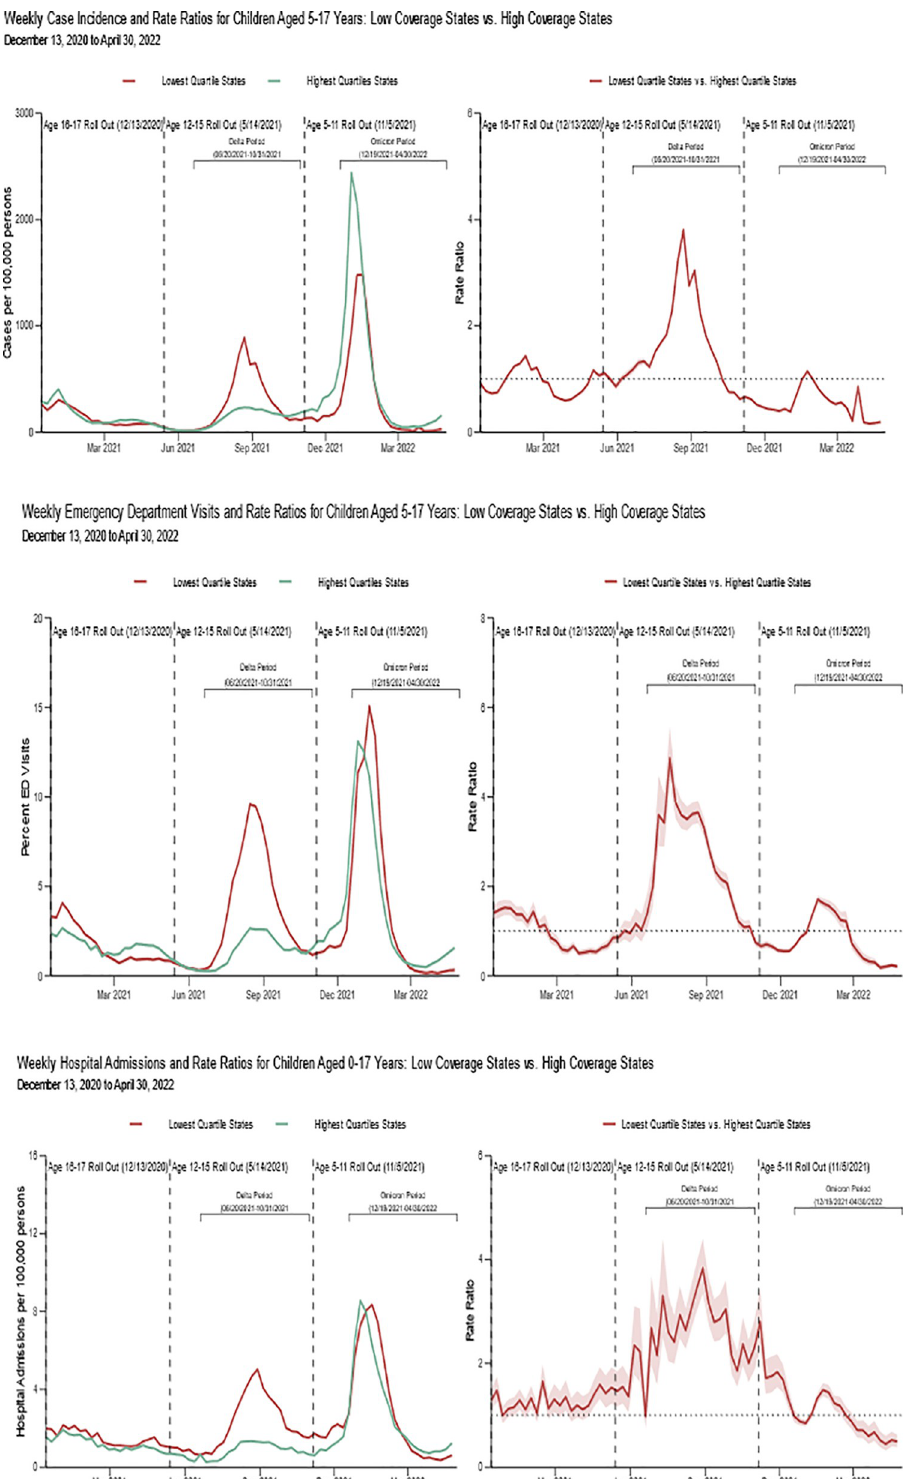
Fig 2. Weekly rate ratios among children aged 5–17 comparing lowest COVID-19 vaccination coverage quartile states to highest coverage quartile states by outcome: December 13, 2020–April 30, 2022. Vaccine coverage estimates for children aged 5–17 years during the first and last week of the Delta and Omicron periods of predominance in the US: (Delta: 9.21% as of the week of June 20 th , 2021, 22.57% the week of October 31,